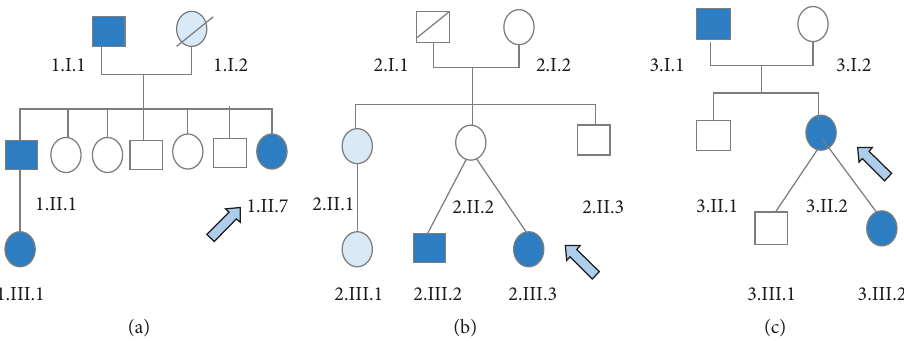
Figure 1: Family trees of the three studied families: families 1 (a), 2 (b), and 3 (c). The members affected by PxD are displayed shaded in dark blue and those affected by epilepsy, in light blue. The cases indicated with an arrow correspond to the index cases.